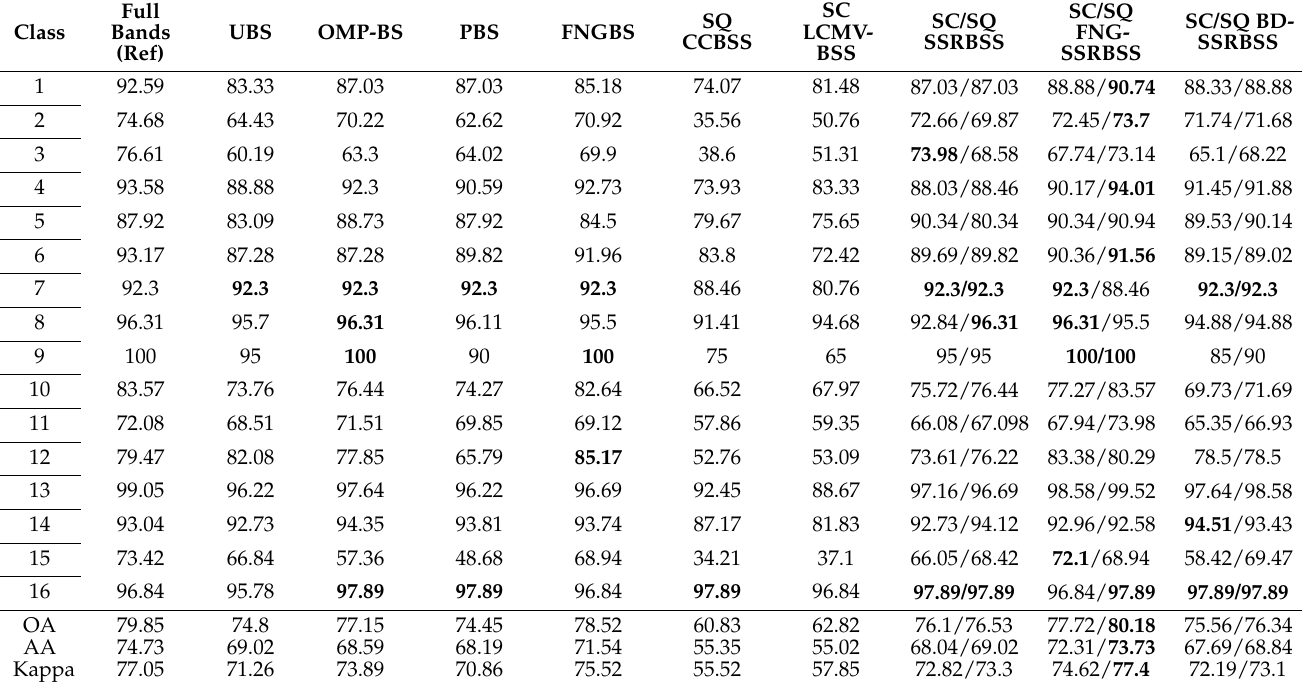
Table 7. SVM classification results of using the bands described in Table 4 for the Purdue